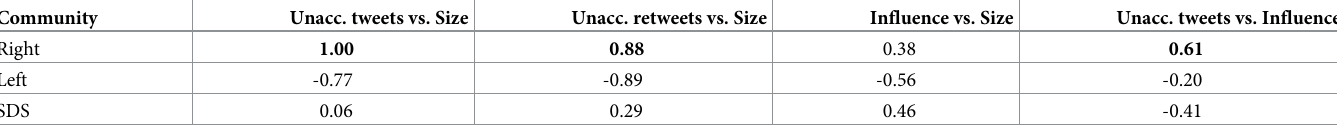
Table 6. Comparison of the three major communities by Cohen’s h . The headings denote the first property (the proportion p 1 ) vs. the second property (the proportion p 2 ). The values of h in the body have the following interpretation: positive sign of h shows that p 1 > p 2 , and the value of | h | indicates the effect size. In bold are the values of h > 0.50, indicating at least medium effect size. Community Unacc. tweets vs. Size Unacc. retweets vs. Size Influence vs. Size Unacc. tweets vs. Influence Right 1.00 0.88 0.38 0.61